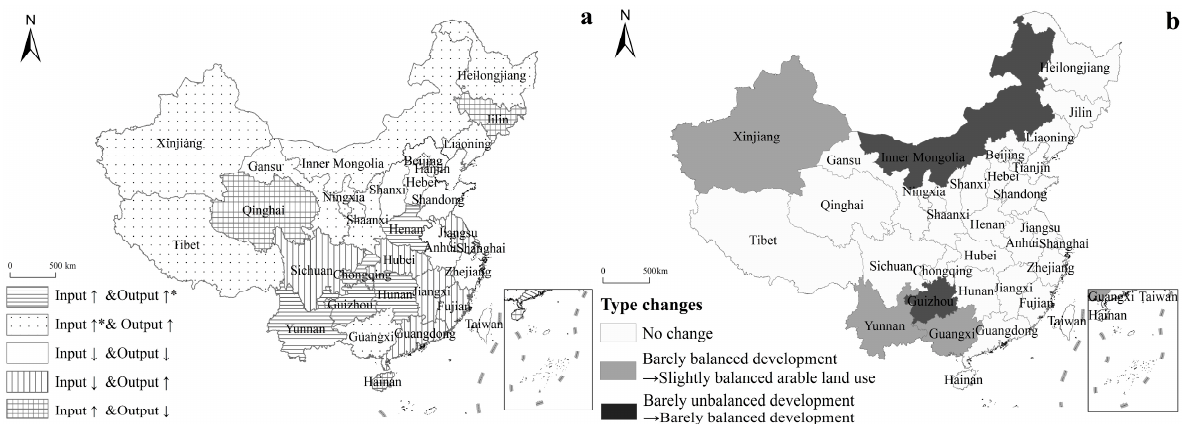
Figure 13. Change of the input–output and the coupling coordination type (the * in Figure 12a indicates the one which changed more. For instance, input ↑ and output ↑ * means the output increased more than the increase of input).